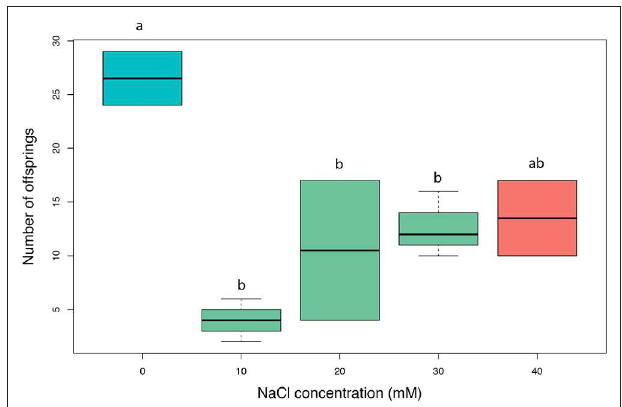
FIGURE 5 | Amount of lime aphid ( Eucallipterus tiliae ) offsprings on single detached leaves of Tilia x vulgaris leaves from seedlings exposed to 0–40mM NaCl, after 5 days of colony